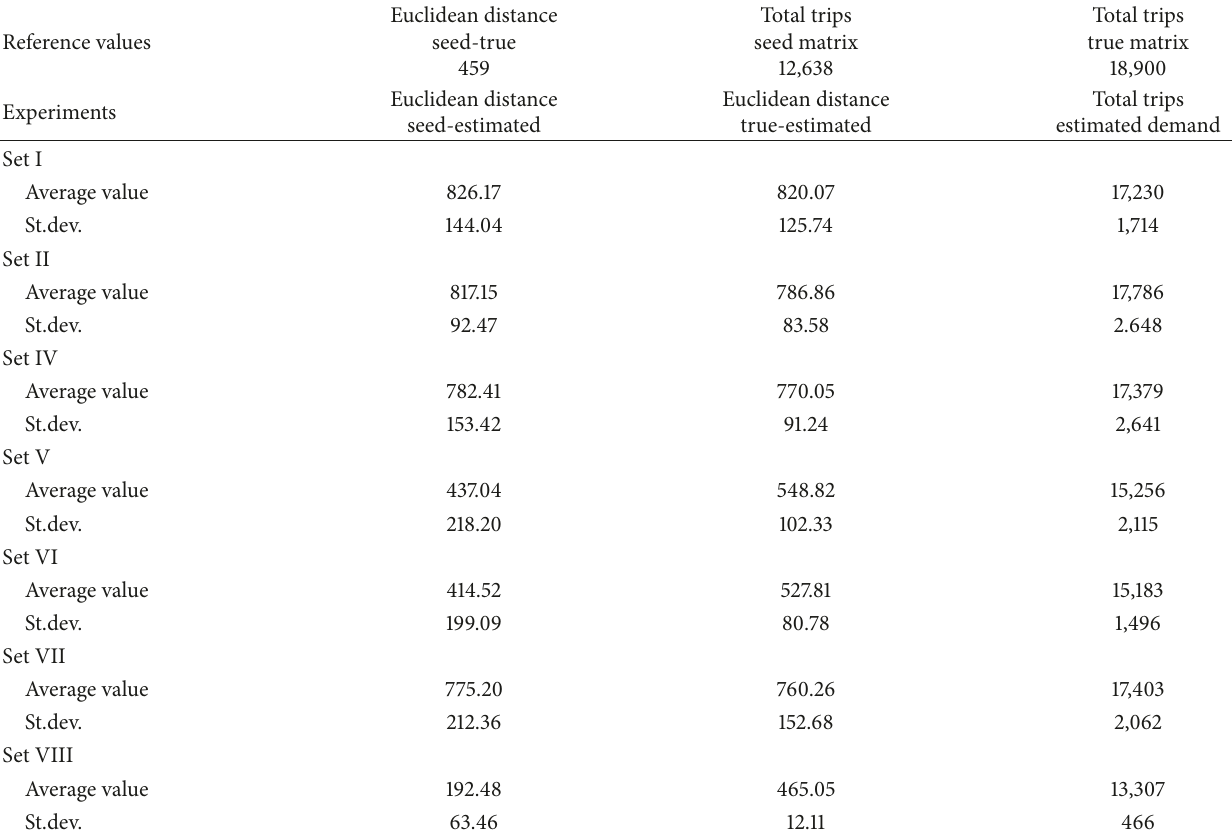
Table 4: Evaluation of the estimated demand as the Euclidean distance from the true O–D matrix and the total number of